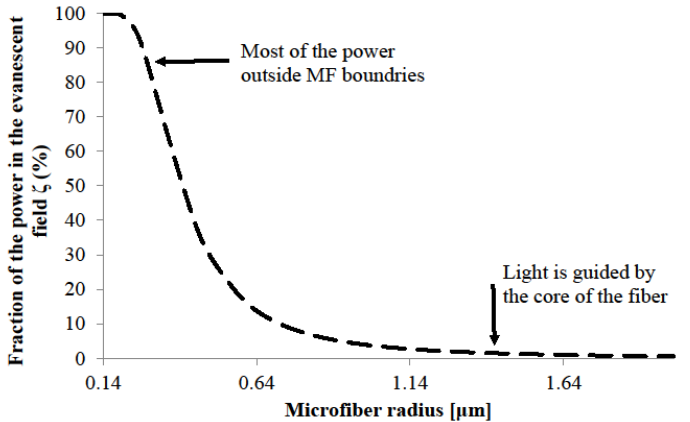
Figure 6. Mode field intensity profile for the HE 11 mode at various MF radii r . The field discontinuity is presented as spikes at the silica-air interface.